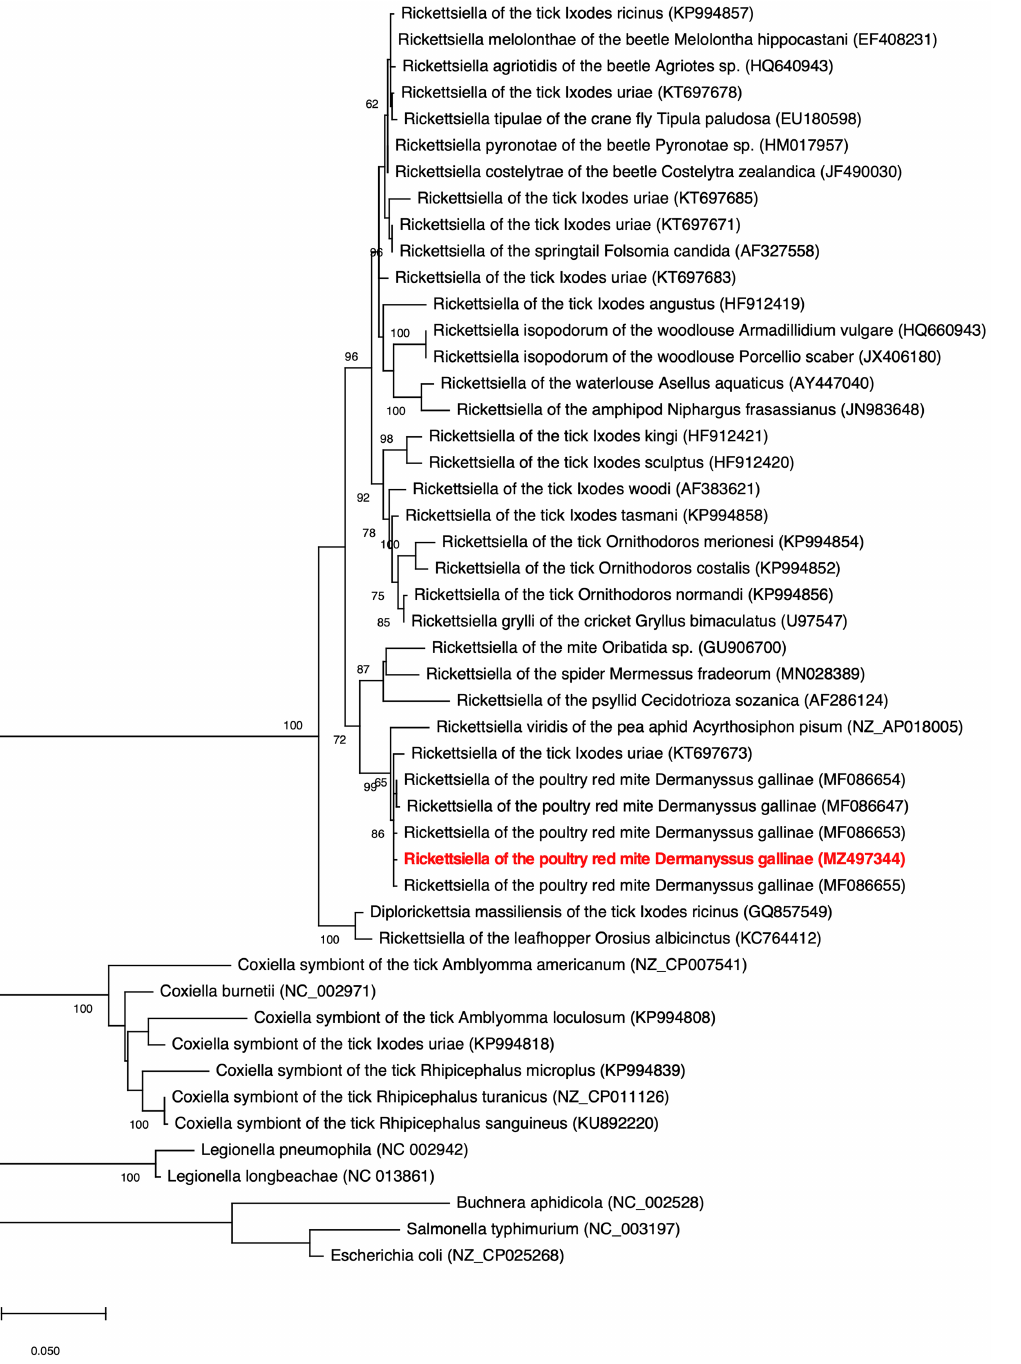
FIGURE 4 | Phylogenetic placement of Rickettsiella DGE in the Gammaproteobacteria. The maximum likelihood phylogeny is inferred from 16S rDNA sequences (1,013 unambiguously aligned nucleotide sites). Statistical support is shown at each node from 1,000 bootstrap replicates (bootstrap values > 60% are shown). The Rickettsiella DGE sequence highlighted in red (MZ497344) was generated in the current study. Accession numbers are indicated in brackets. Scale bar represents 0.02 substitutions per